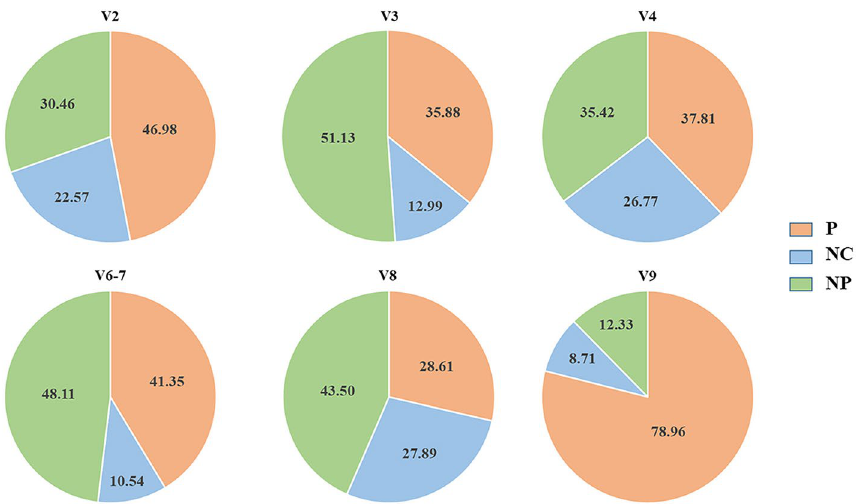
Figure 1. Proportions of “ potential pathogenic bacteria ” (P) which was defined with ASVs with the same (e.g., at the genus level in both RDP and Pplacer) or complementary (e.g., at family level in RDP and genus and species levels in Pplacer) taxonomic assignments from both classifiers; (2) “ no consistent pathogenic bacteria ” (NC) which was defined as ASVs with discordant taxonomic classifications between classifiers; and (3) “ no pathogenic bacteria ” (NP) detected among the analyzed hypervariable regions (V2 to V9).